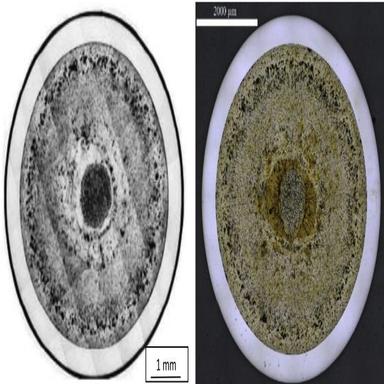
High magnification optical image of the central region from 501-G591, showing also the secondary phases inferred to be precipitates of rare earths and Am/ Cm.